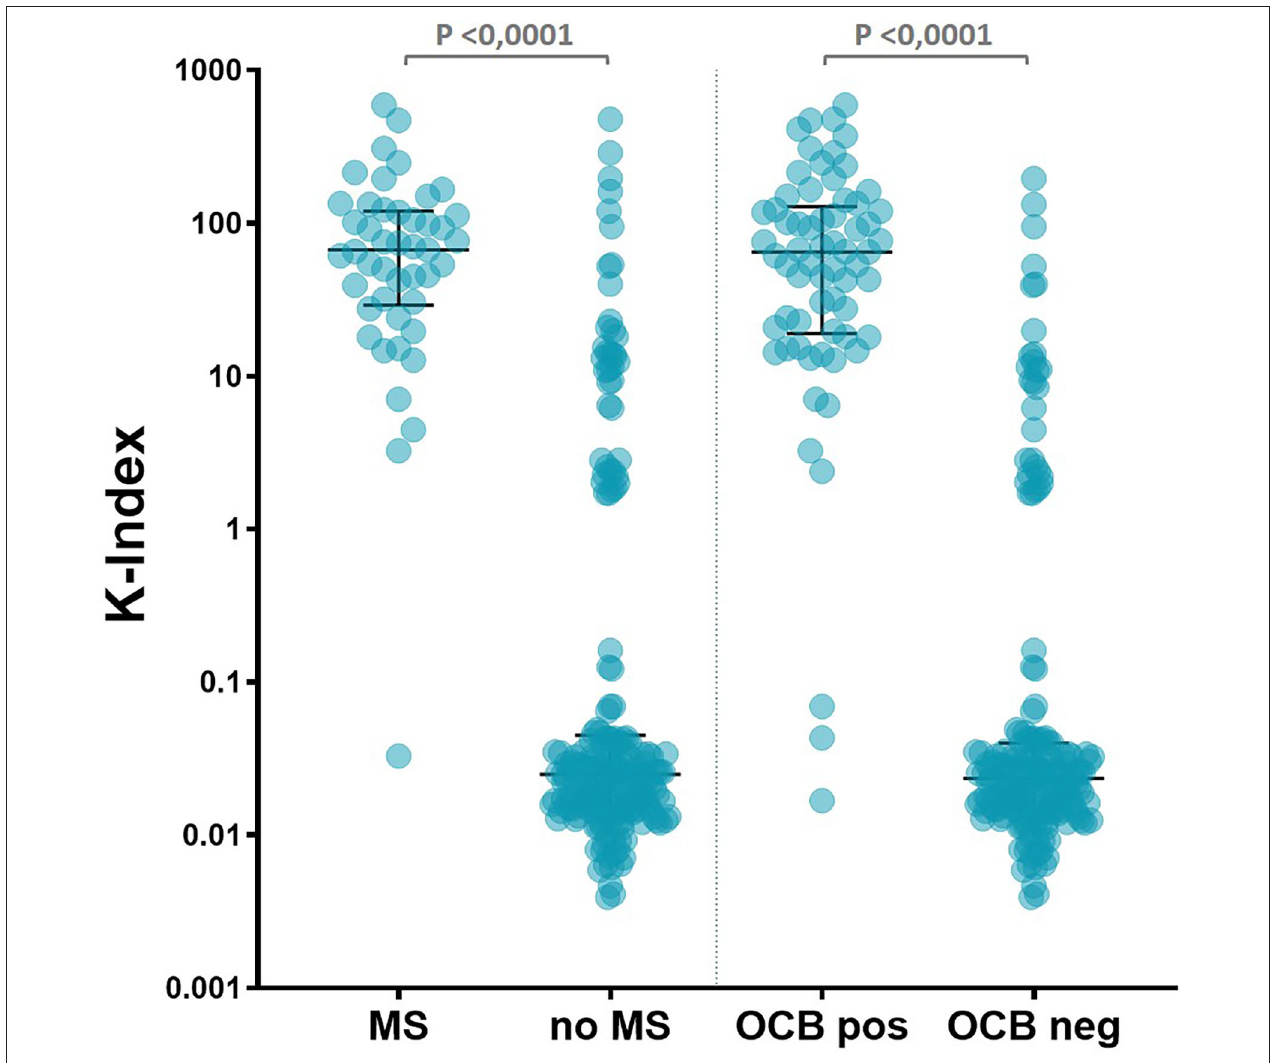
FIGURE 2 | K-Index individual values, group medians, and interquartile range, from patients with MS, without MS, positive OCB, and negative OCB. Significantly different group medians ( p < 0.0001) by Mann–Whitney test. K-Index, kappa index; MS, multiple sclerosis; OCB, oligoclonal